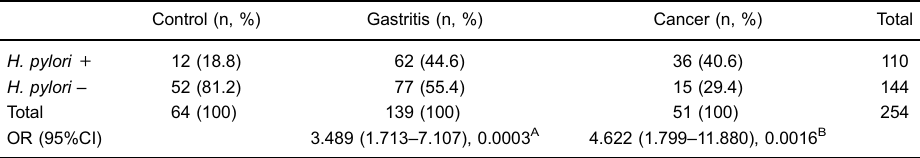
Table 2. Frequency of Helicobacter pylori infection in Control, Gastritis, and Cancer groups. Control (n,